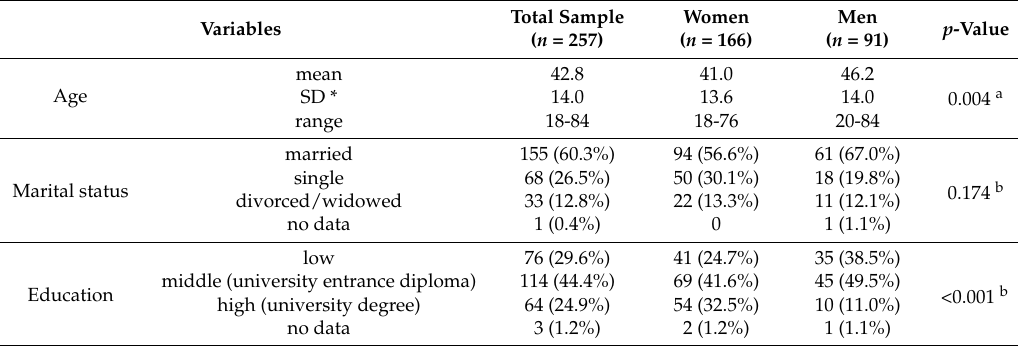
Table 1. Sociodemographic, socio-economic, and immigrant-specific sample characteristics, and differences by